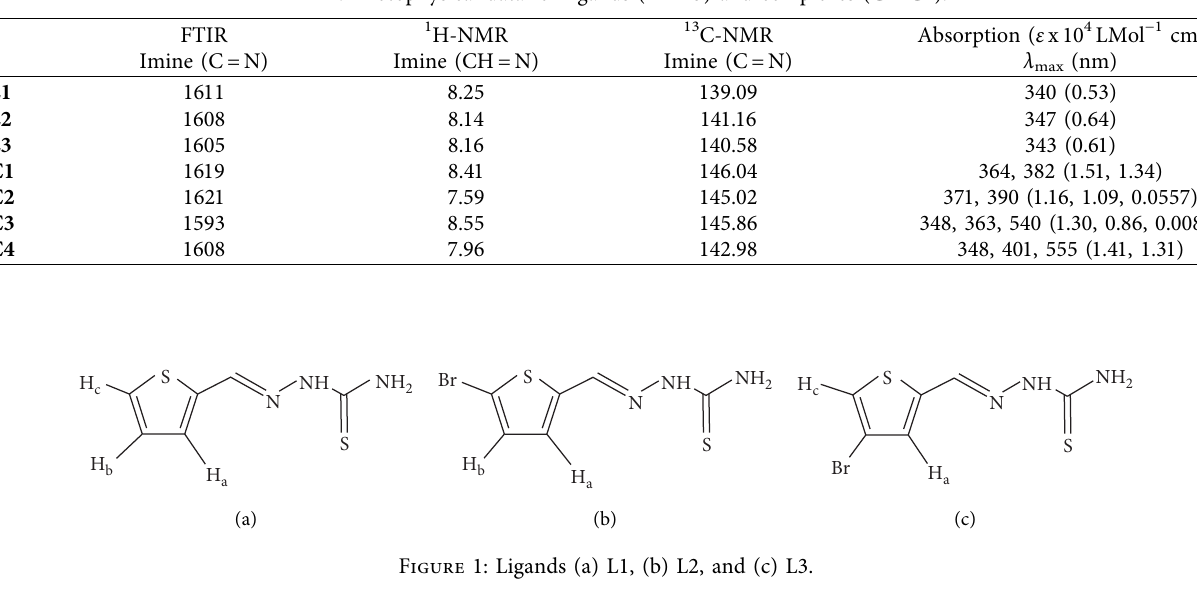
Table 1: Photophysical data for ligands ( L1–L3 ) and complexes ( C1–C4 ).